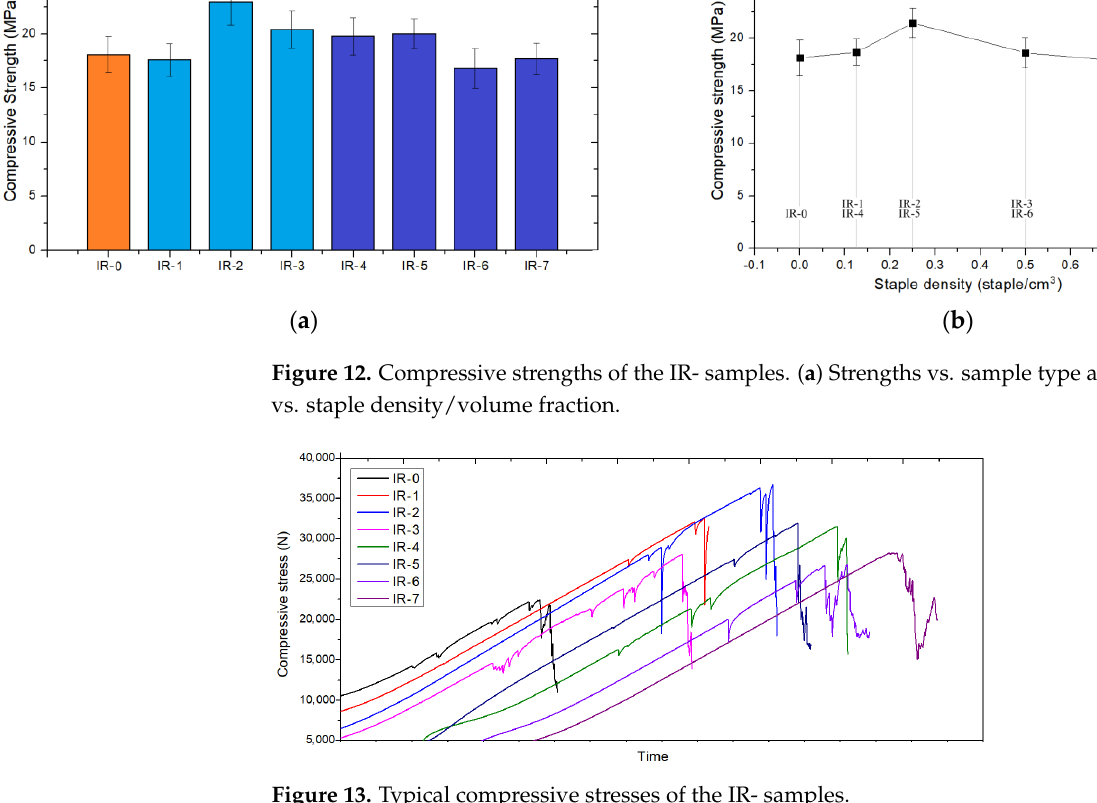
Figure 13. Typical compressive stresses of the IR- samples.